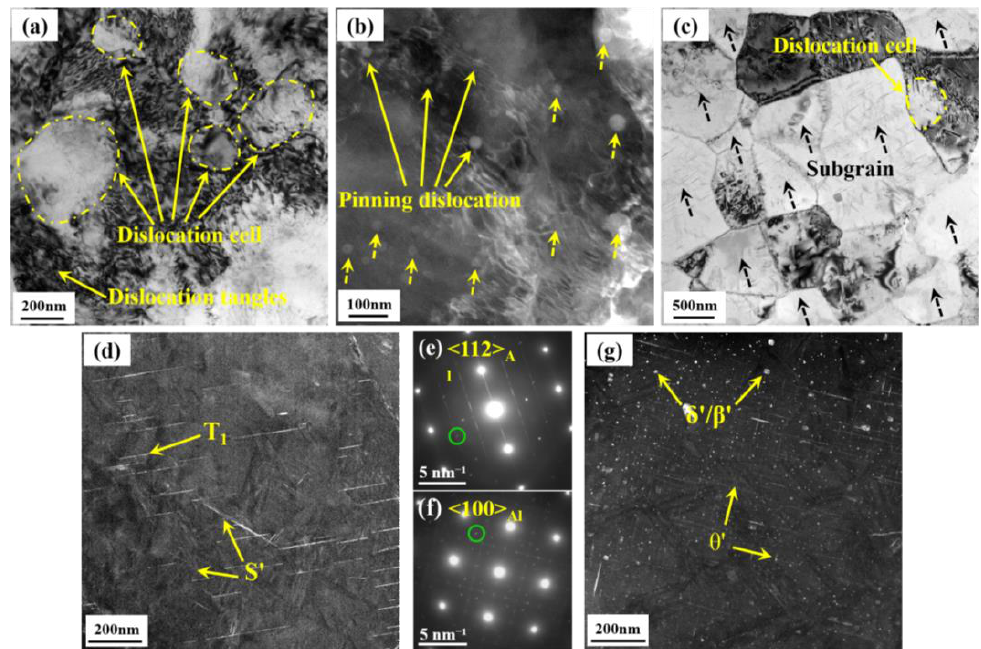
Figure 5. TEM images of alloy with rolling reduction of 81.4% in different states: ( a ) Dislocation morphology of hot-rolled sample; ( b ) HAADF STEM image of spherical particles of hot-rolled sample; ( c ) Substructure of T6 treated sample; ( d ) DF TEM image of T6 treated sample captured from <112> Al zone axis and corresponding SAED pattern of ( e ); ( f ) SAED pattern of T6 treated sample captured from <100> Al zone axis and corresponding DF TEM image of ( g ).